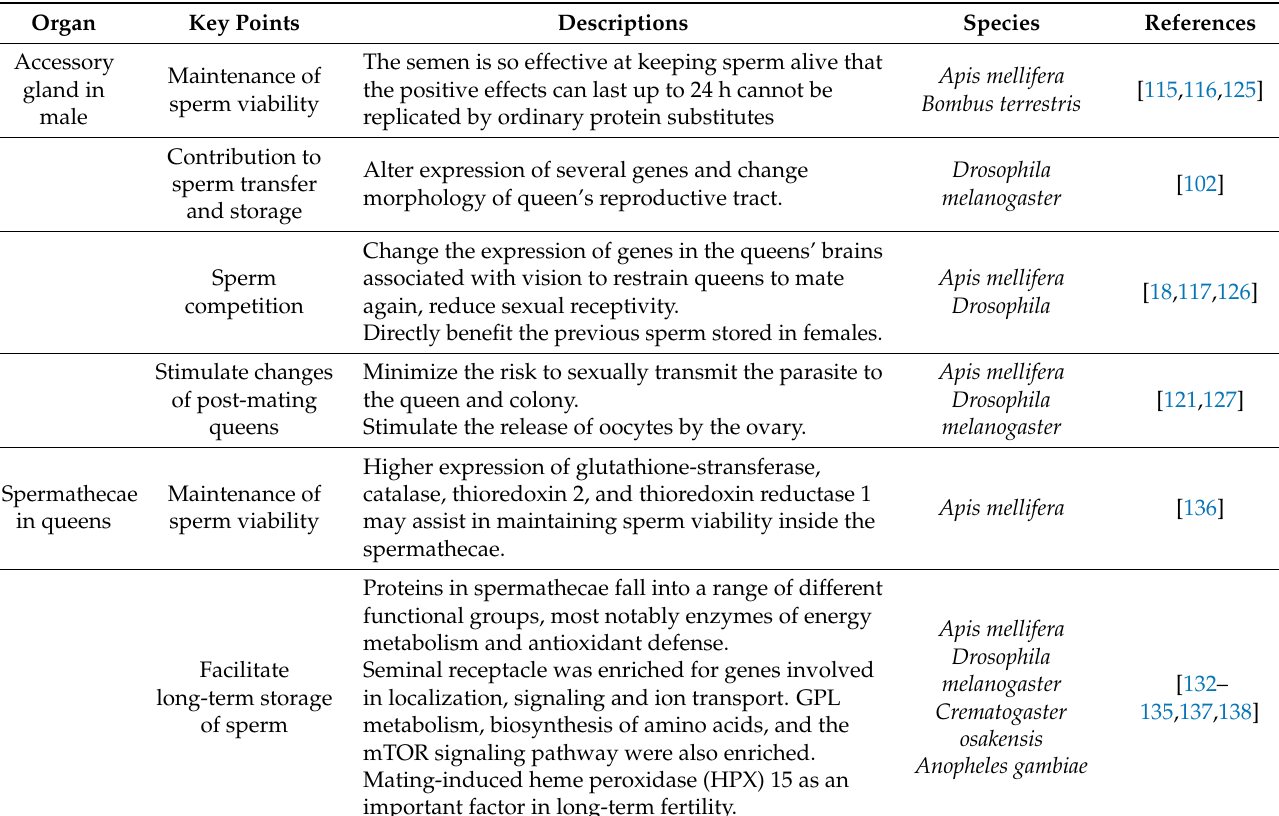
Table 1. Functions of proteins in accessory gland of male insects and in spermathecae of queen insects presented throughout the